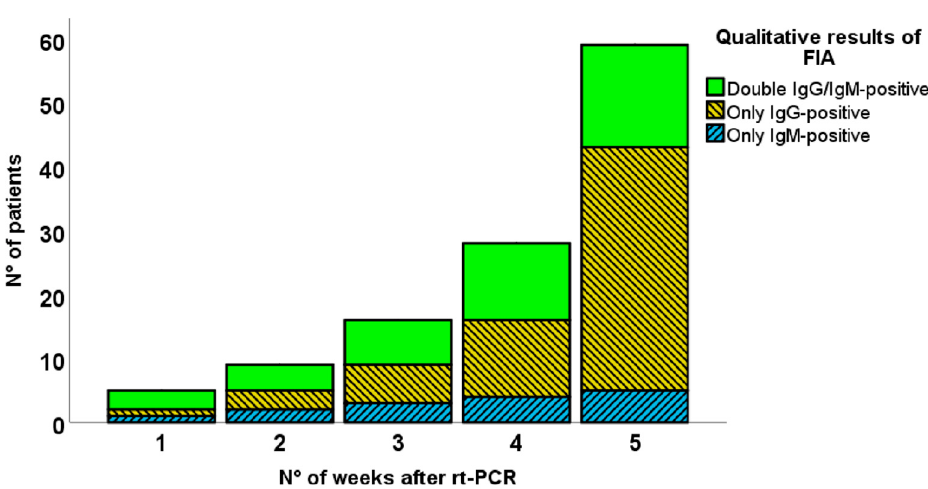
Figure 2. Cumulative results of serological tests relative to the time from first COVID-19 diagnosis through rRT-PCR.